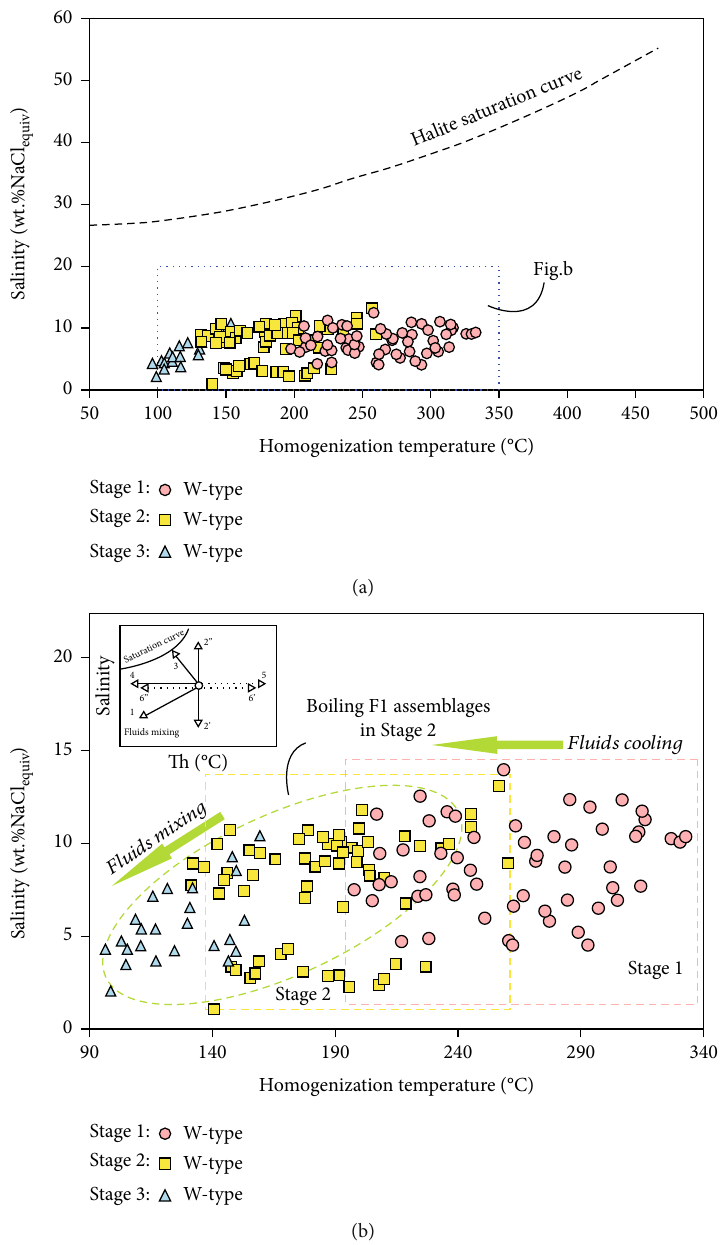
Figure 13: Th vs. salinity of fl uid inclusions in the Longmendian deposit (a). Possible fl uid evolution trends shown in the temperature – salinity plot